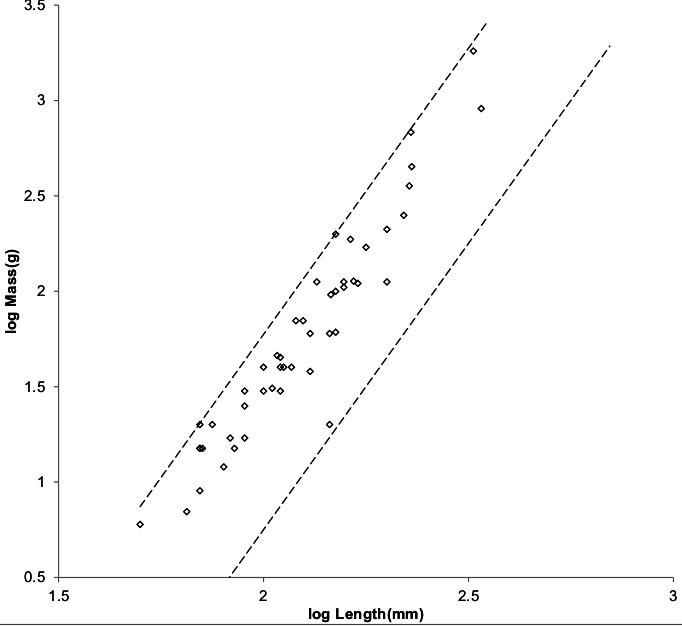
Log body mass as a function of log head and body length for Cricetidae.The data are from Nowak (1999). The dashed lines are MMLE sturdiness factor boundaries. The upper boundary was generated with a sturdiness factor s = (3)0.5. The lower boundary was generated with s = (3)−0.5. The boundary lines are for geometric similarity. Cricetids are marked by open diamonds. \documentclass[12pt]{minimal}
\usepackage{amsmath}
\usepackage{wasysym}
\usepackage{amsfonts}
\usepackage{amssymb}
\usepackage{amsbsy}
\usepackage{upgreek}
\usepackage{mathrsfs}
\setlength{\oddsidemargin}{-69pt}
\begin{document}
}{}${R}_{M}^{2}=1.0$\end{document}RM2=1.0.